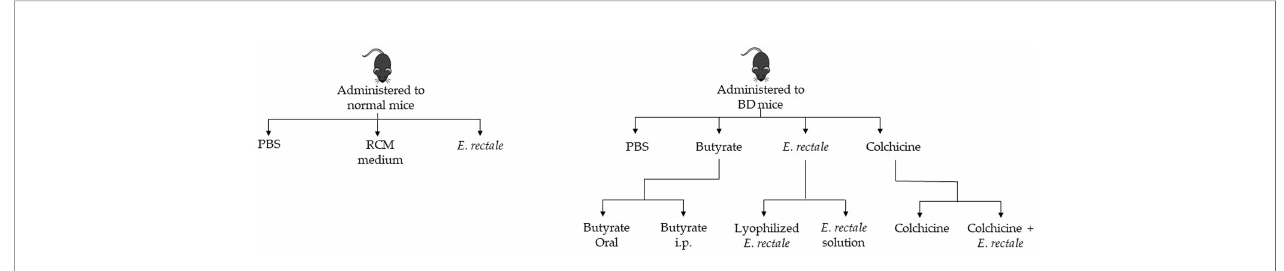
FIGURE 1 | Schematic diagram of the in vivo